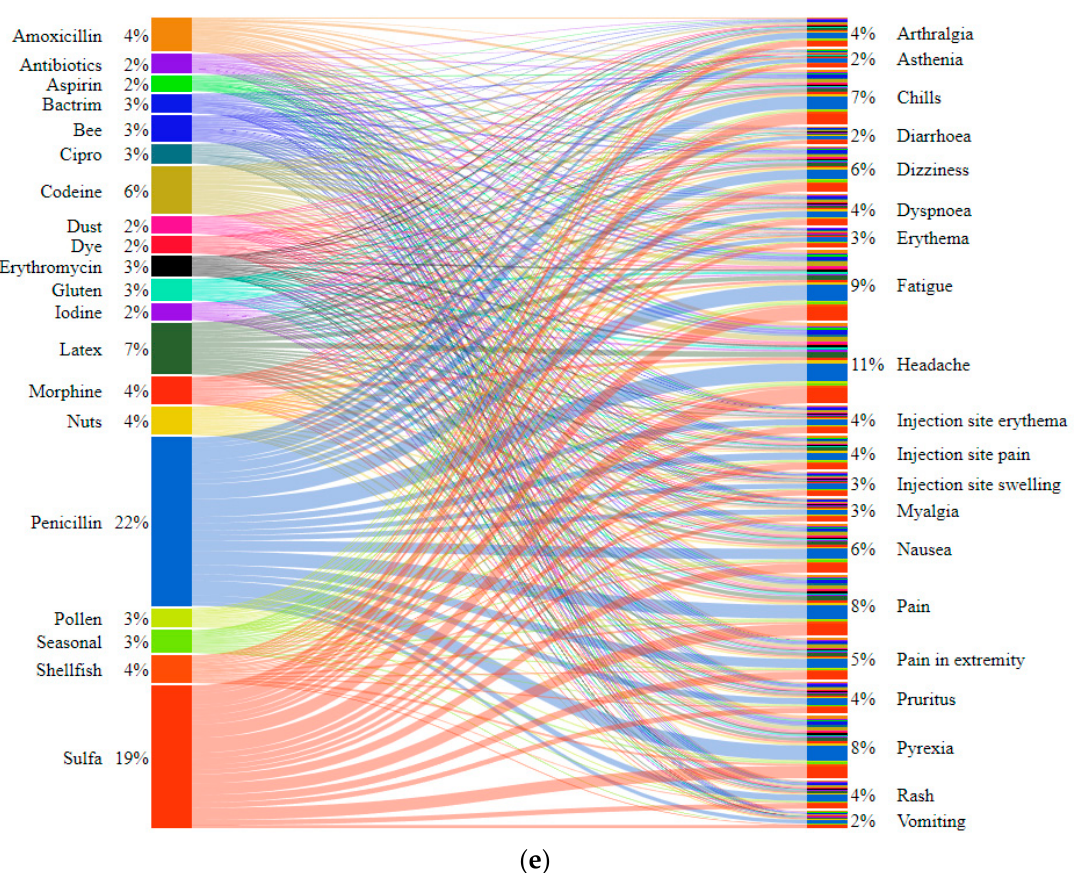
Figure 5. Bipartite graphs for the correlations of 20 most commonly reported AEs with the 3 vaccine producers (Pfizer-BioNTech, Moderna, and Janssen). ( a ) Shows the distribution of the entire VAERS dataset with respect to all the vaccine producers, and ( b – d ) show the distributions of the effects with respect to each vaccine. ( e ) Shows the correlations of 20 most commonly reported AEs with reported allergies in VAERS data. The allergies penicillin and sulfa collectively appear to be in 41% of the 643,522 VAERS